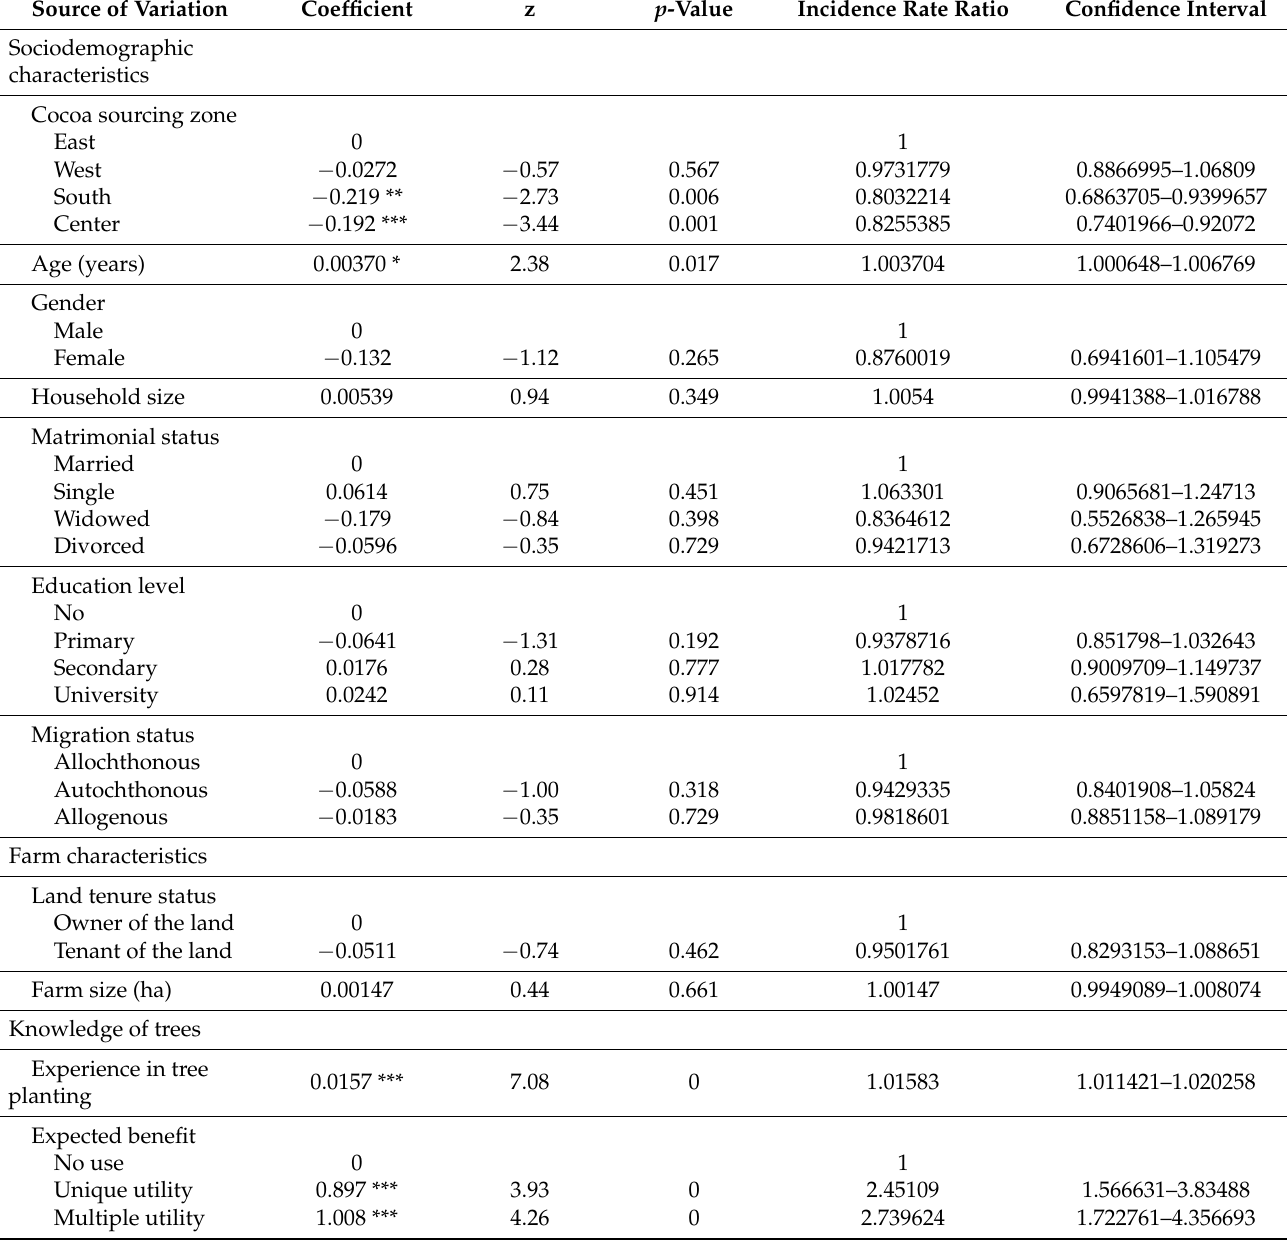
Table 2. Generalized Poisson regression model estimates of the factors driving tree species planting on cocoa farms in C ô te